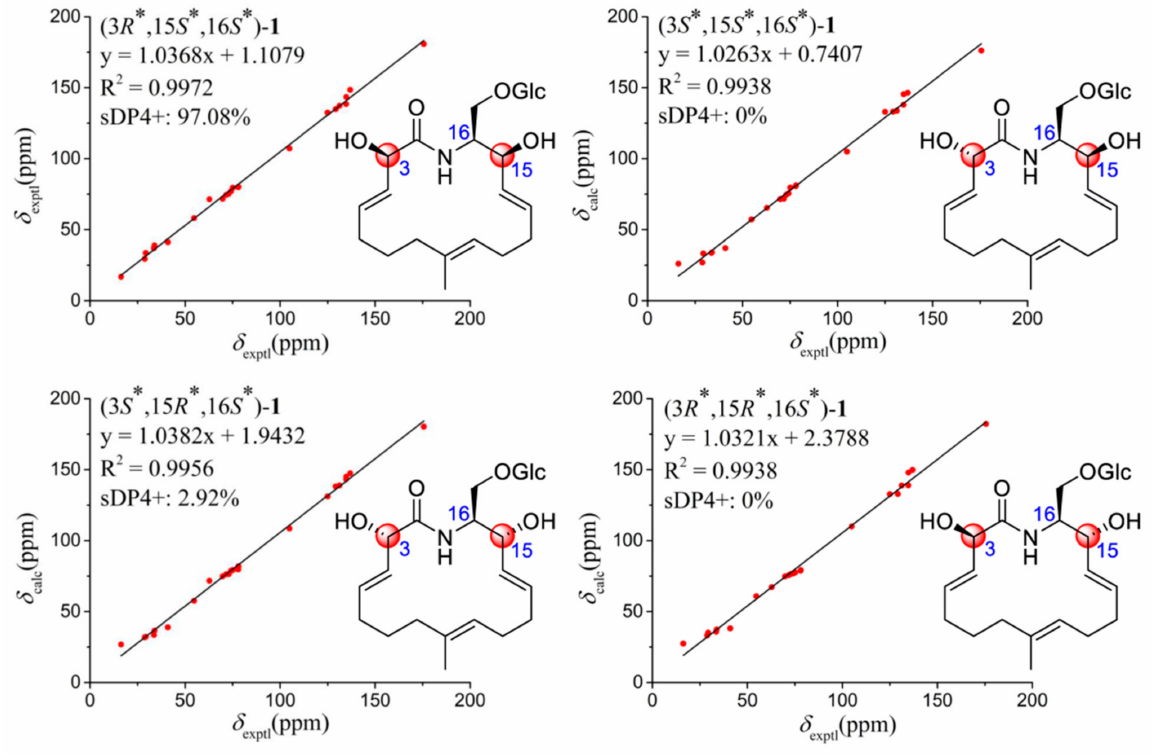
Figure 3. Linear correlation plots of calculated-experimental 13 C NMR chemical shift values